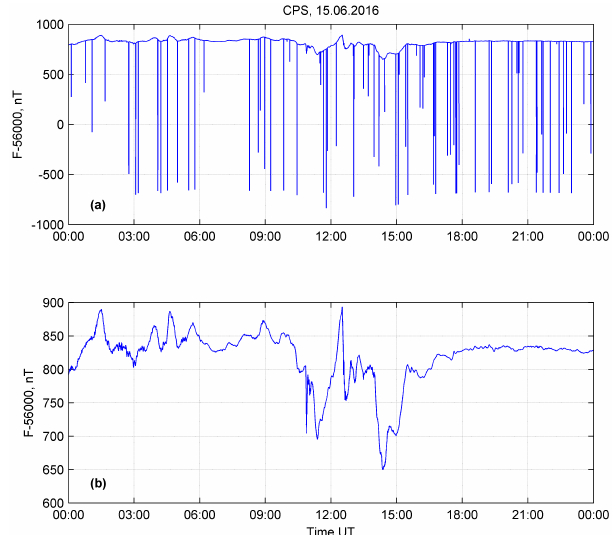
Figure 4. An example of spikes in the results of measurements by Overhauser magnetometer POS-1 at the Cape Schmidt observatory. (a) The total intensity F raw record, (b) signal after noise removal.